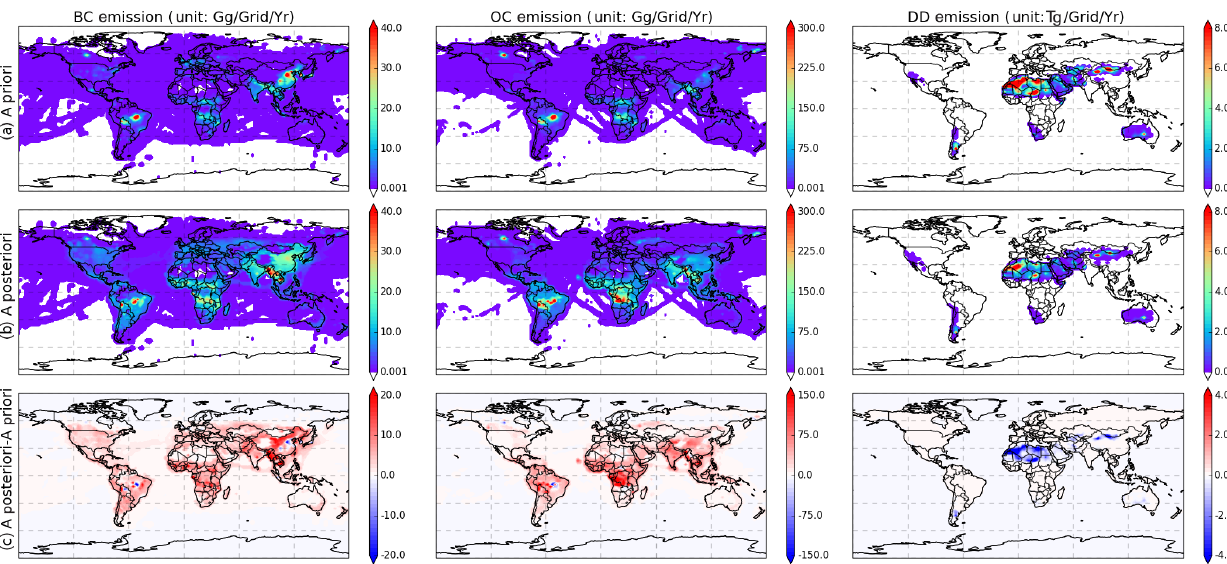
Figure 2. Global distribution of emissions for 2010 for BC (left column), OC (middle column) and DD (right column) based on (a) a priori, (b) a posteriori emission datasets, and the differences between a posteriori and a priori emissions (c) .